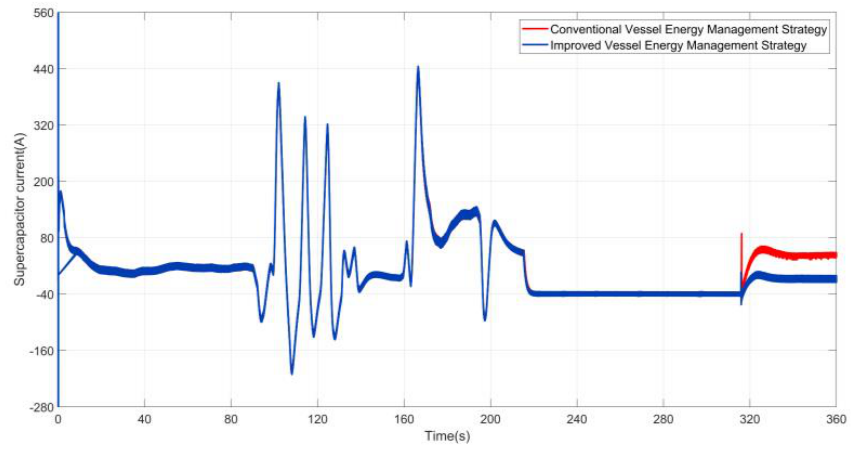
Figure 27. Variation in the supercapacitor output current under different strategies. Generally, the bus voltage fluctuation range is ± 5% of the rated voltage, and the maxi- mum does not exceed ± 10%. From the bus voltage fluctuation in Figure 28, it can be seen that the bus voltage fluctuation reaches up to 579 V in the conventional strategy and up to 570 V in the improved strategy, and the bus voltage pulsation is within a reasonable